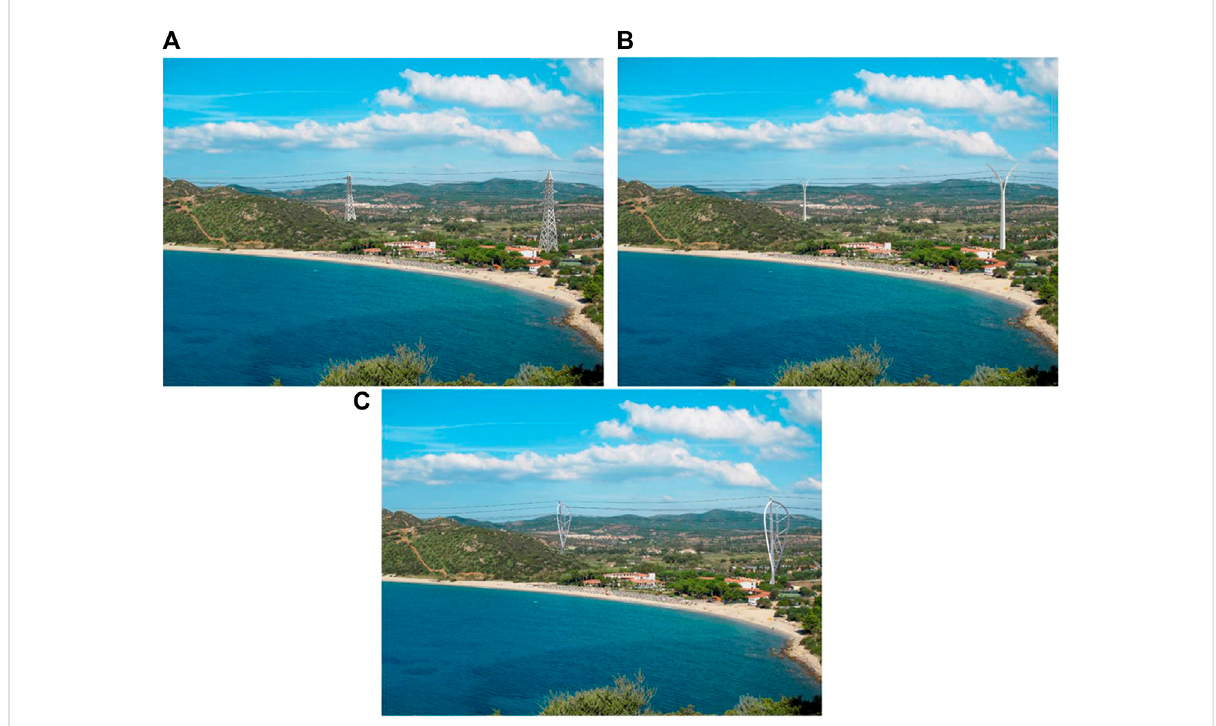
FIGURE 14 Rendering of standard pylon (A) , Rosental pylon (B) , and proposed pylon (C) in a coastal